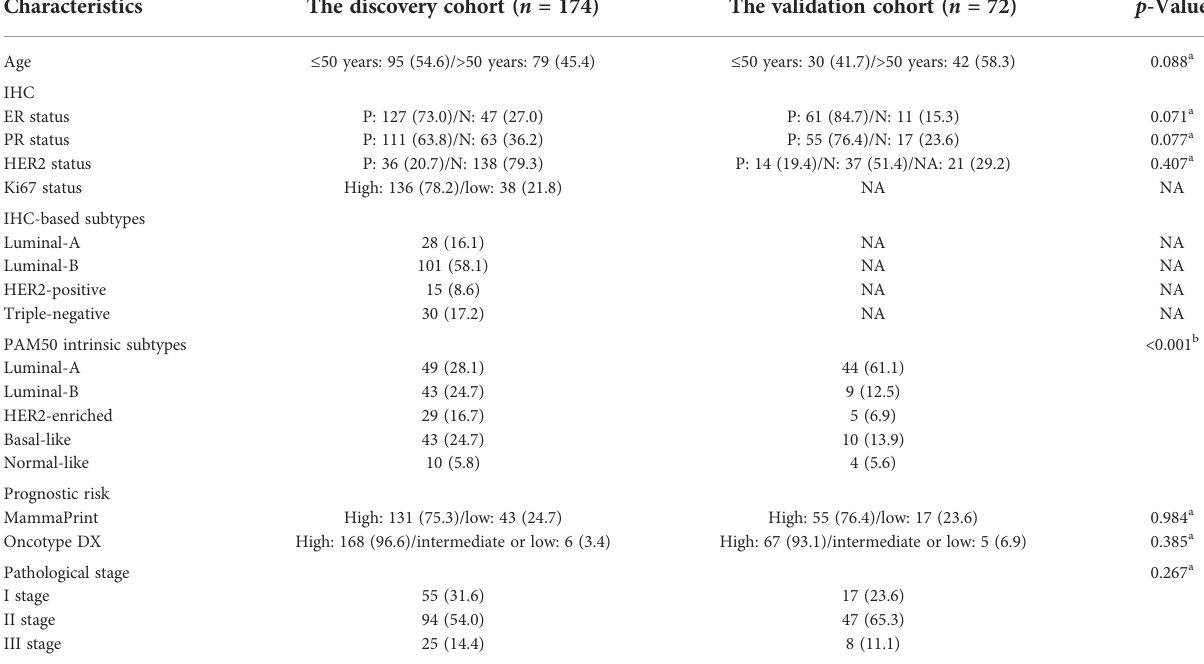
TABLE 1 The clinical and transcriptomic characteristics in two cohorts.